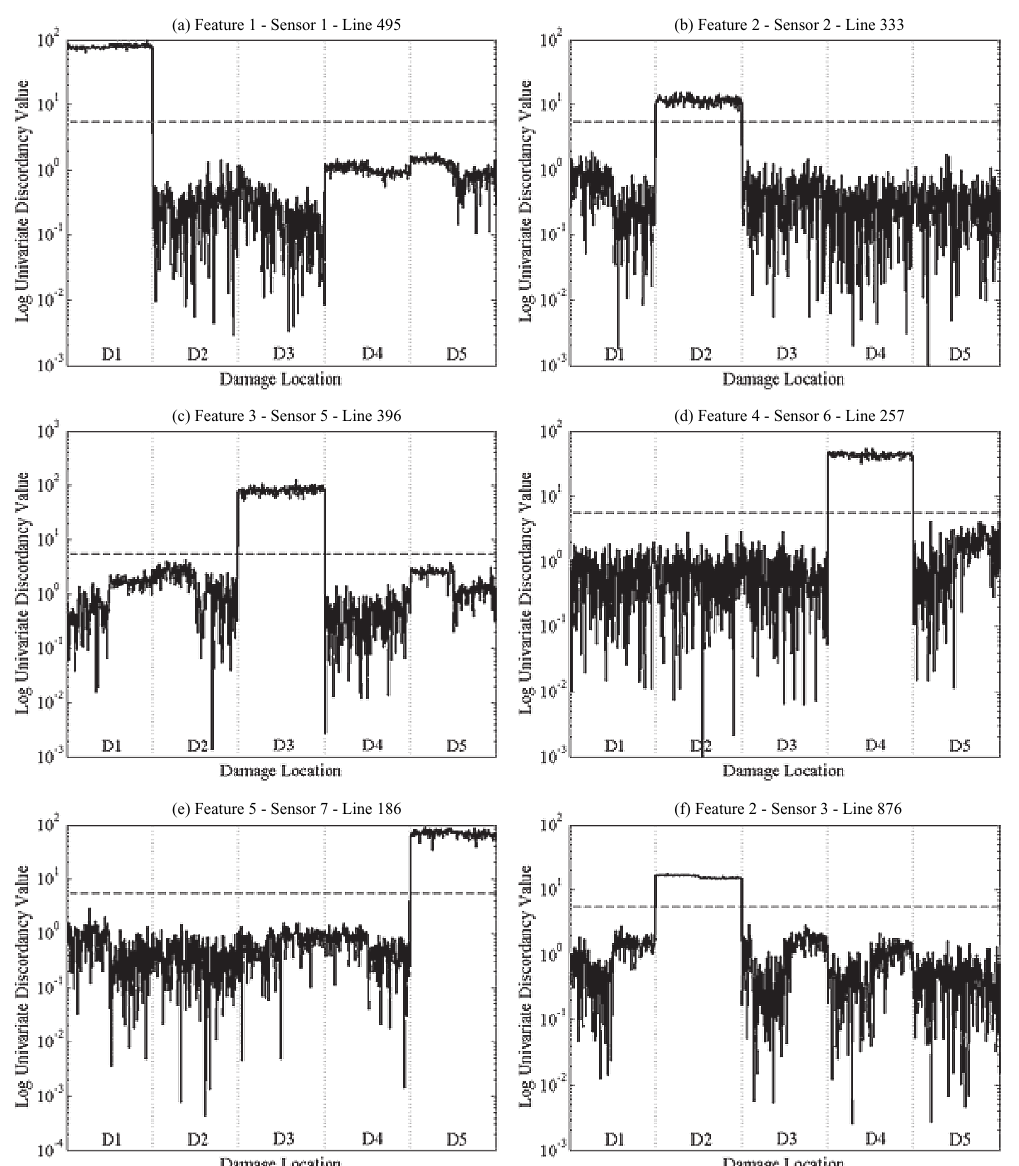
Fig. 5. Univariate outlier results for selected advanced features when presented with single site damage. 3.90, 4.75 and 2.80 for feature 1, 2, 3, 4 and 5 respectively. The only slight problem which arose concerned the standby feature 2 (ie. not using sensor 2 data but rather spectral line 876 from sensor 3) which resulted in 1 out